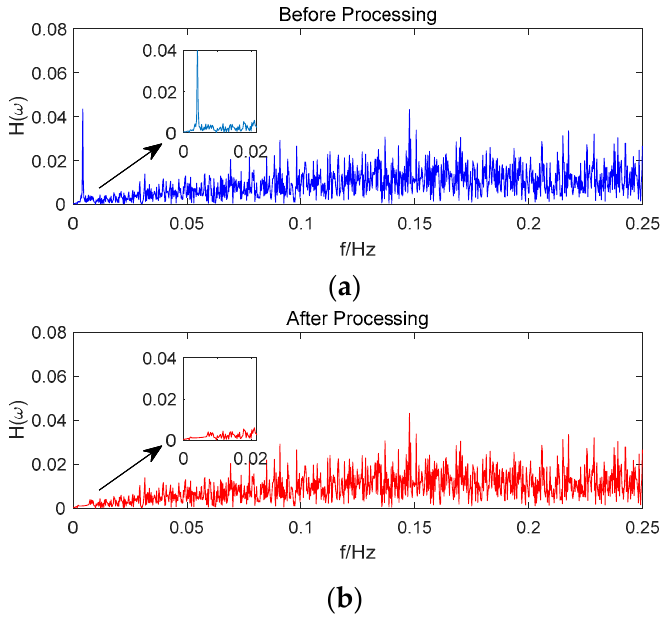
Figure 15. ( a ) Frequency spectrum before smoothing with the spectrum peaks extracting method and CMCD correction model, C06, ( b ) Frequency spectrum after smoothing with the spectrum peaks extracting method and CMCD correction model, C06.